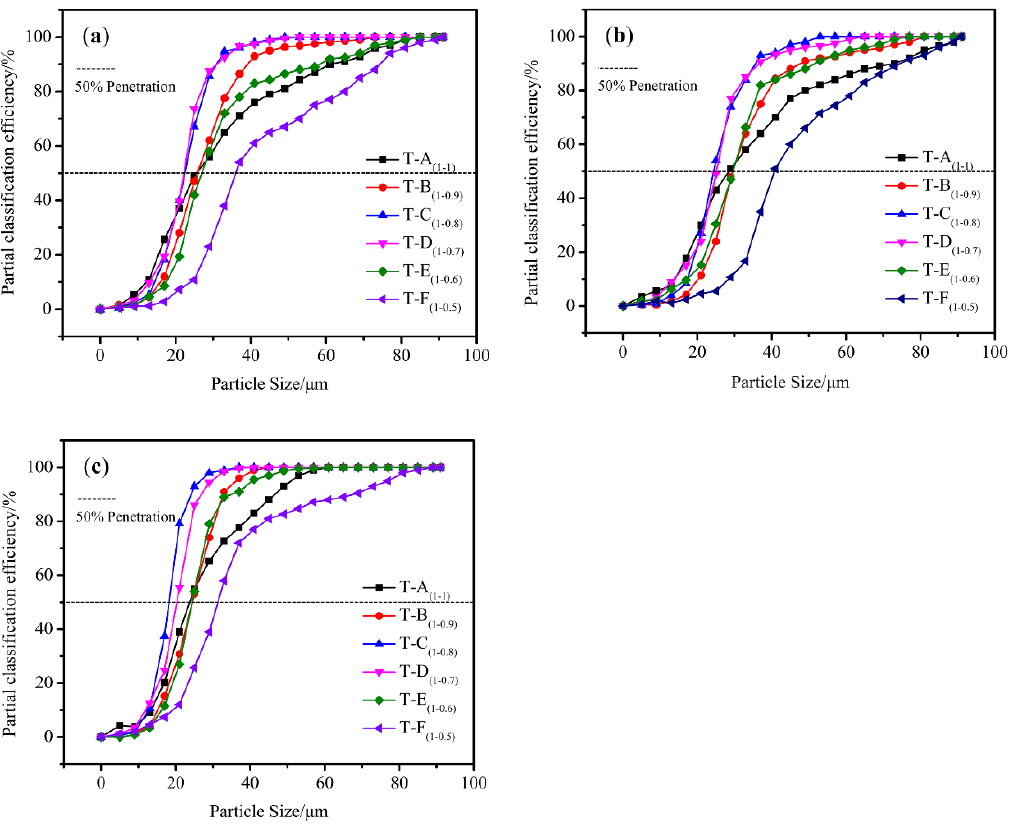
Figure 14. Comparison of Tromp curves for six different rotor cage models: ( a ) 13.5 m/s–470 rpm, ( b ) 16 m/s–470 rpm, and ( c ) 13.5 m/s–670 rpm. Table 5. Comparison of d 50 and K for the six different rotor cage models (13.5 m/s–470 rpm). Model